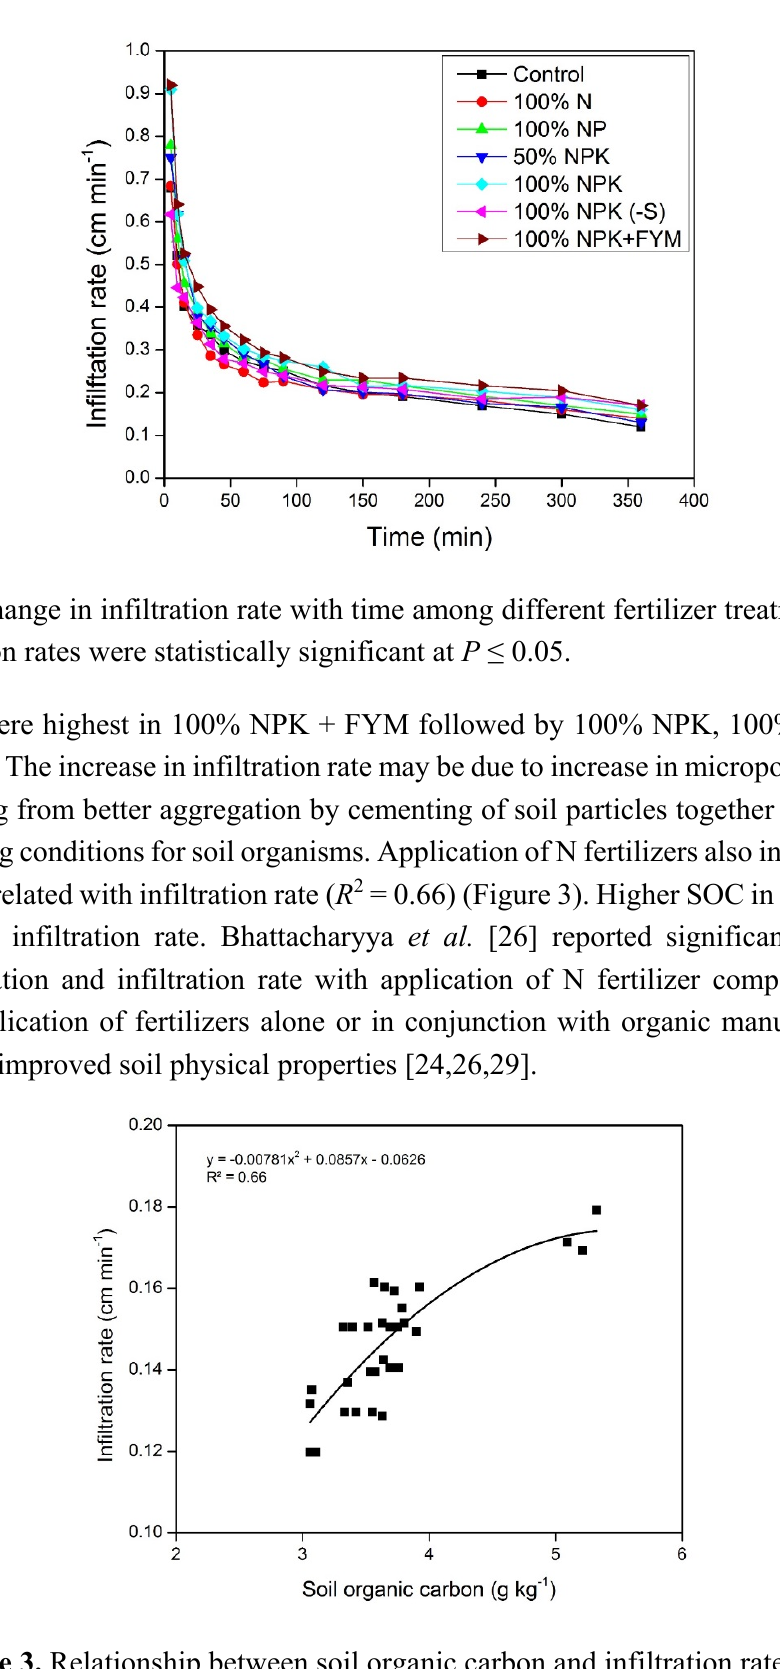
Figure 3. Relationship between soil organic carbon and infiltration